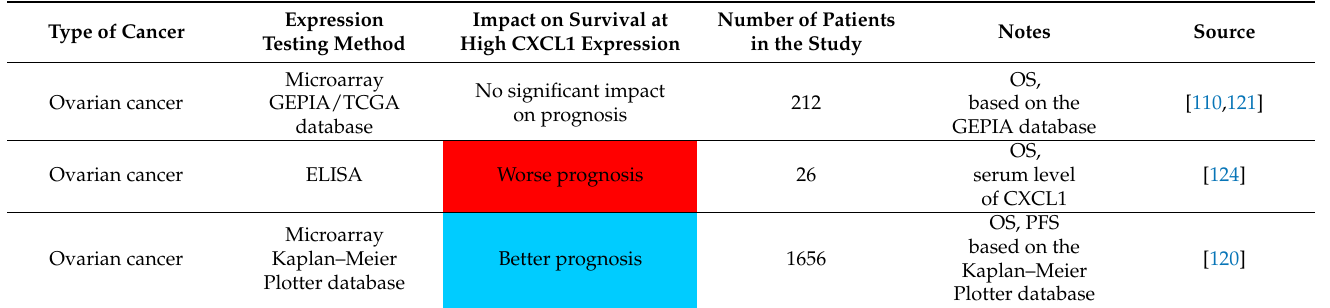
Table 4. Effect of CXCL1 expression level on survival of ovarian cancer